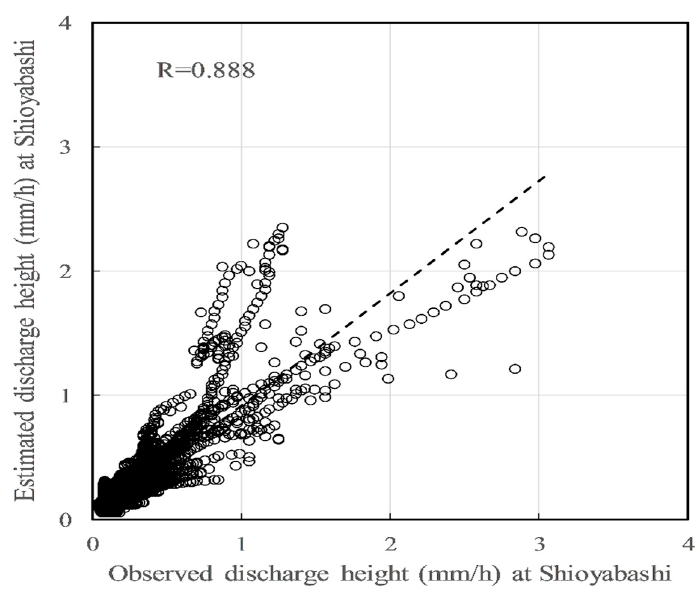
Figure 4. Tank model estimated with 2009 precipitation